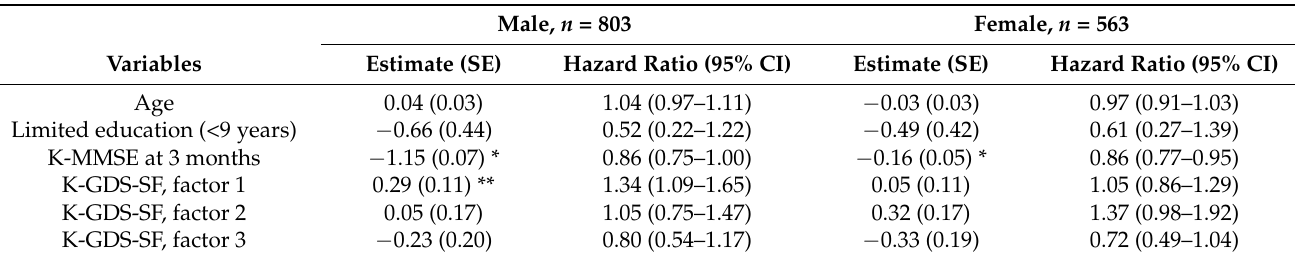
Table 4. K-GDS-SF factors associated with higher hazard ratios by sex in older